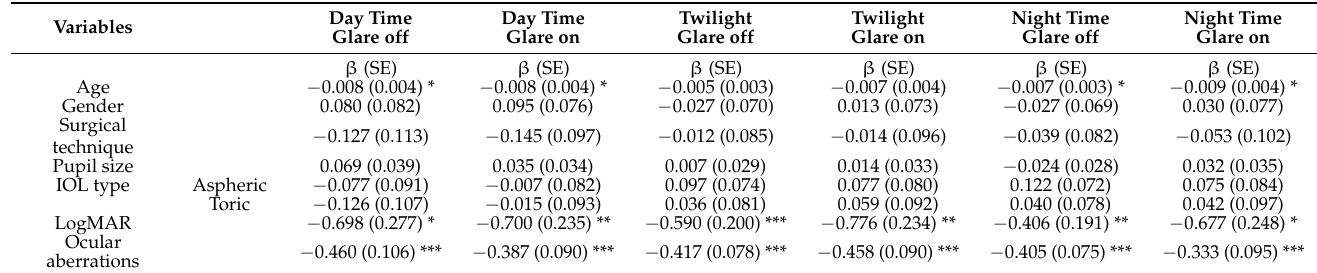
Table 4. Multivariate generalized estimating equation (GEE) analysis of contrast sensitivity under every luminance condition with or without glare